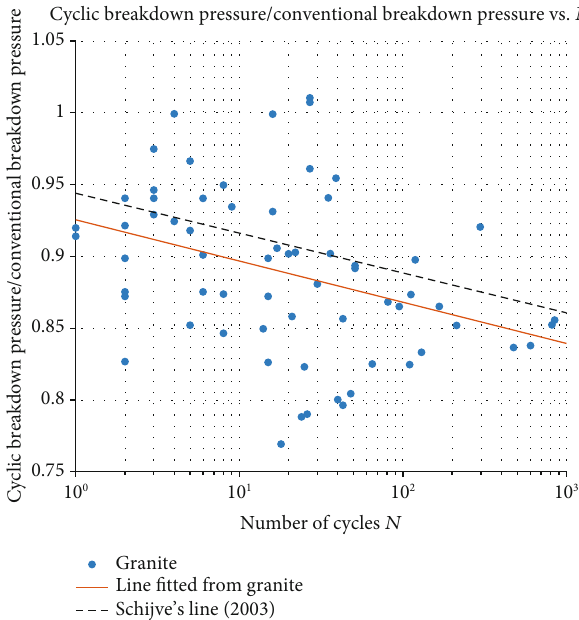
Figure 10: Normalized breakdown pressure (cyclic breakdown pressure/conventional breakdown pressure) versus the number of cycles N .